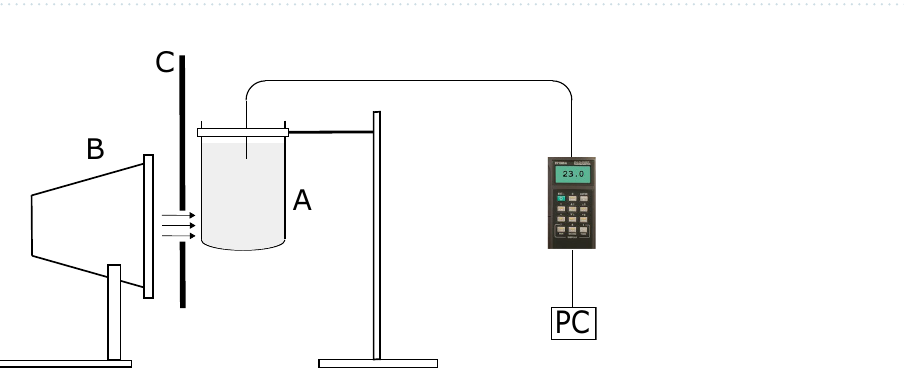
Figure 3. Energy-dispersive X-ray spectroscopy of the coffee particles. The most dominant elements were carbon and oxygen.